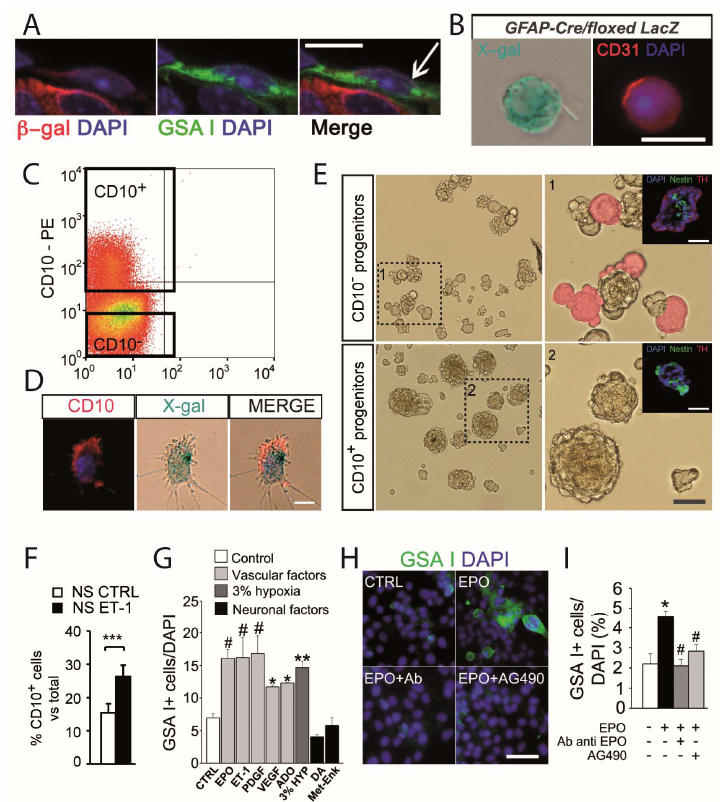
Figure 4. Carotid body progenitors of the mesenchymal lineage. ( A ) Confocal microscopy images from a CB section of a hypoxic GFAP-cre/floxed LacZ mouse, immunostained with an antibody against β-galactosidase (red) and stained with the endothelial marker GSA I (green). An endothelial cell (EC) derived from a GFAP-positive type II cell is pointed with an arrow. Scale bar, 10 µm. ( B ) Example of a GFAP-positive cell-derived CD31-positive EC, found in a CB cell dispersion from GFAP-cre/floxed LacZ mouse. Scale bar, 20 µm. ( C ) Dot-plot showing detection of CD10-positive cells in rat CB by flow cytometry. ( D ) Immunocytochemistry of dispersed CB cells from GFAP-cre/floxed LacZ transgenic mice to perform cell-fate mapping analyses to demonstrate that CD10-positive cells originate from CB multipotent cells. Scale bar, 10 µm. ( E ) Bright field pictures of neurospheres obtained in culture from CD10-positive FACS sorted cells. 1 and 2 show details of areas squared, with differentiated blebs pseudocolored in red. Insets in 1 and 2 show immunohistochemical images of CD10-negative (1) and CD10-positive (2) cell-derived neurosphere thin sections, stained for nestin (green) and TH (red). Scale bars, 50 µm. ( F ) FACS quantification of CD10-positive cells in dispersed neurospheres with and without ET-1 treatment. Error bars represent SEM *** p < 0.01. ( G ) Quantification graph indicating the average number of GSA-positive cells among total cells in different culture conditions. Error bars represent SEM. * p < 0.05 and ** p < 0.01; # p < 0.001, one-way ANOVA Newman–Keuls post hoc test compared to CTRL measurement. ( n = 3 cultures). ( H ) Images displaying endothelial cell differentiation within adherent cultures of primary neurospheres in the presence of EPO, EPO combined with EPO neutralizing antibody, or EPOR inhibitor (AG490). Scale bar, 50 µm. ( I ) Quantification graph indicating the percentage of GSA I-positive cells in different culture conditions. Error bars represent SEM. * p < 0.05, one way ANOVA Newman–Keuls post hoc test compared to control measurement (white bar), and # p < 0.05, one way ANOVA Newman–Keuls post hoc test compared to EPO treated measurement (black bar) ( n = 3 cultures). Panels A, B and G to H modified from [29] , and panels C to F modified from [30] .